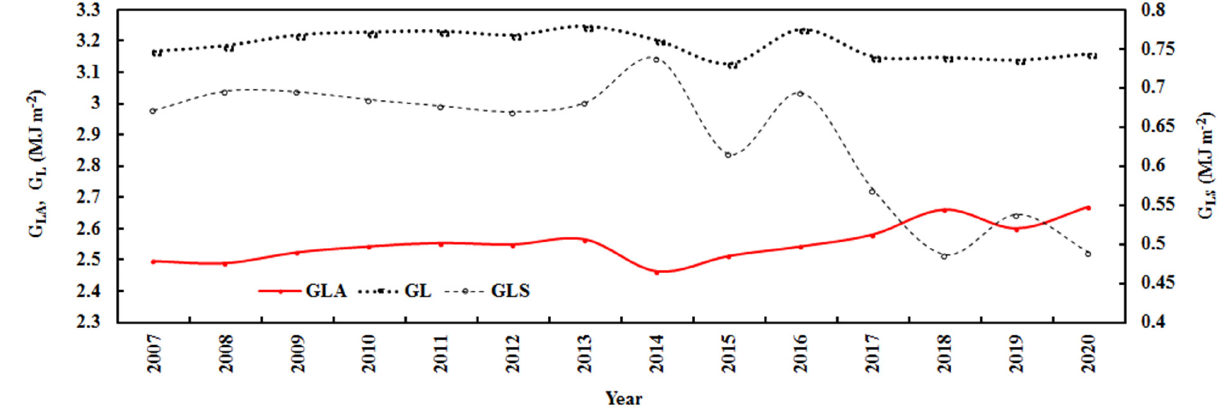
increased by 0.42% per year, associated with an increase in E of 0.37%; G LS decreased by 2.00% per year, associated with a decrease in AF of 1.46%; and annual G L decreased by 0.14% per year.